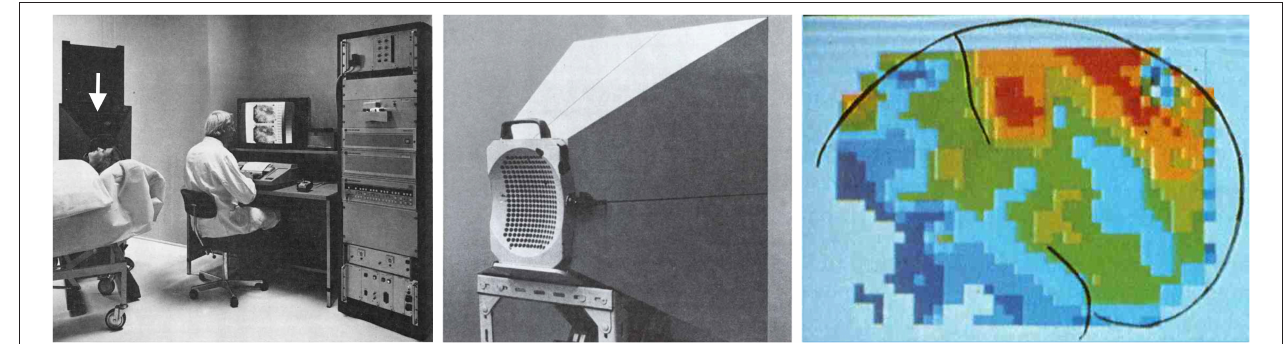
FIGURE 1 | Functional neuroimaging in humans started with 2D scintigraphic imaging of cerebral blood flow. An experimental set-up is shown in the left panel. The arrow points to a gamma camera equipped with a cone beam collimator similar to the collimator shown in the middle panel. The cone-beam collimator is placed close to the subject’s head. The gamma camera is a 254 detector camera developed by Per Rommer and Edda Sveinsdottir under the leadership of Niels A. Lassen at Meditronic and commercialized by Medimatic under the name “Dynamatic 254” (Images reprinted with permission from Per Rommer). An example of the images obtained with this set-up is shown in the right panel. Brain contours and the central sulcus are outlined in black. The image shows CBF during hand gripping with the contralateral hand. Reprinted with permission from the American Medical Association. Copyright © (1976) American Medical Association. All rights reserved